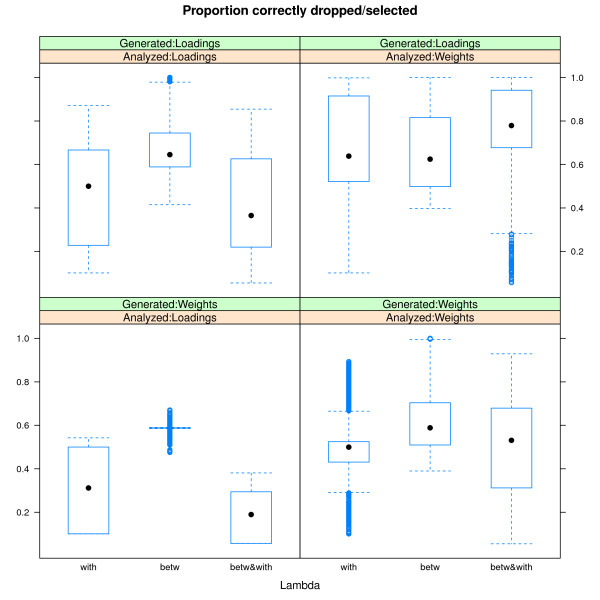
Comparing sparse weights versus sparse loadings. Boxplots for the proportion of correctly classified variables. Within panels, the boxplots are displayed in function of the block structure present in the variable selection. The upper panels refer to data generated under a model with sparse loadings, the lower panels to data generated under a model with sparse weights. The panels at the left were obtained when analyzing the data with a model based on sparse weights; the panels at the right with a model based on sparse loadings.